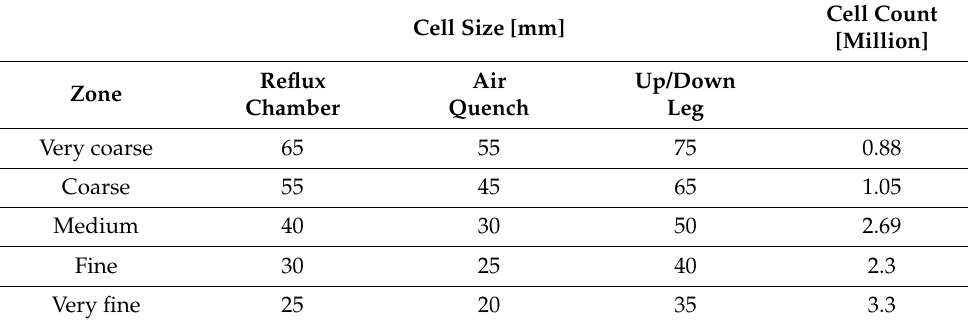
Table 8. Mesh specification for mesh sensitivity